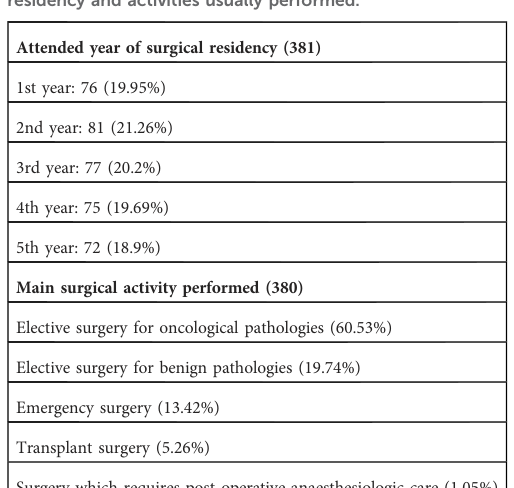
TABLE 2 Subdivision of respondents according to year of residency and activities usually performed.